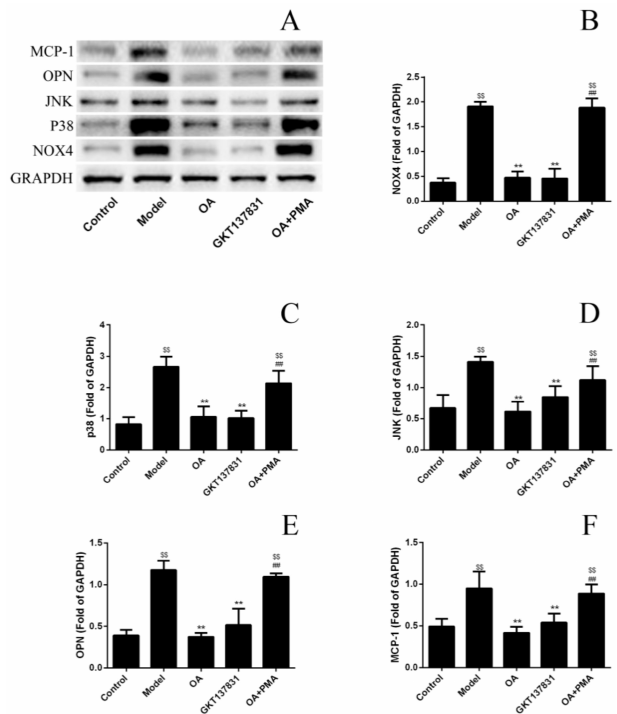
Figure 5. E ff ects of Obcordata A (OA) on the expression of the NOX4 / ROS / p38 MAPK pathway and kidney stones–related proteins in HK-2 cells damaged by calcium oxalate crystals. ( A ) Immunoreactive protein bands representing glyceraldehyde 3-phosphate dehydrogenase (GAPDH), NOX4, p38, c-Jun N-terminal kinase (JNK), osteopontin (OPN), and monocyte chemoattractant protein-1 (MCP-1) relative expression. ( B – F ) Quantitative band intensity data statistical results of NOX4, P38, JNK, OPN, and MCP-1. OA can reduce the expression of NOX4 proteins and downgrade the NOX4 / ROS / p38 MAPK pathway, thereby reducing the expression levels of downstream inflammatory factors MCP-1 and OPN. This mediation disappears after joining PMA. n = 3 independent experiments. ** P < 0.01 versus model group; $$ P < 0.01 versus control group; ## P < 0.01 versus OA